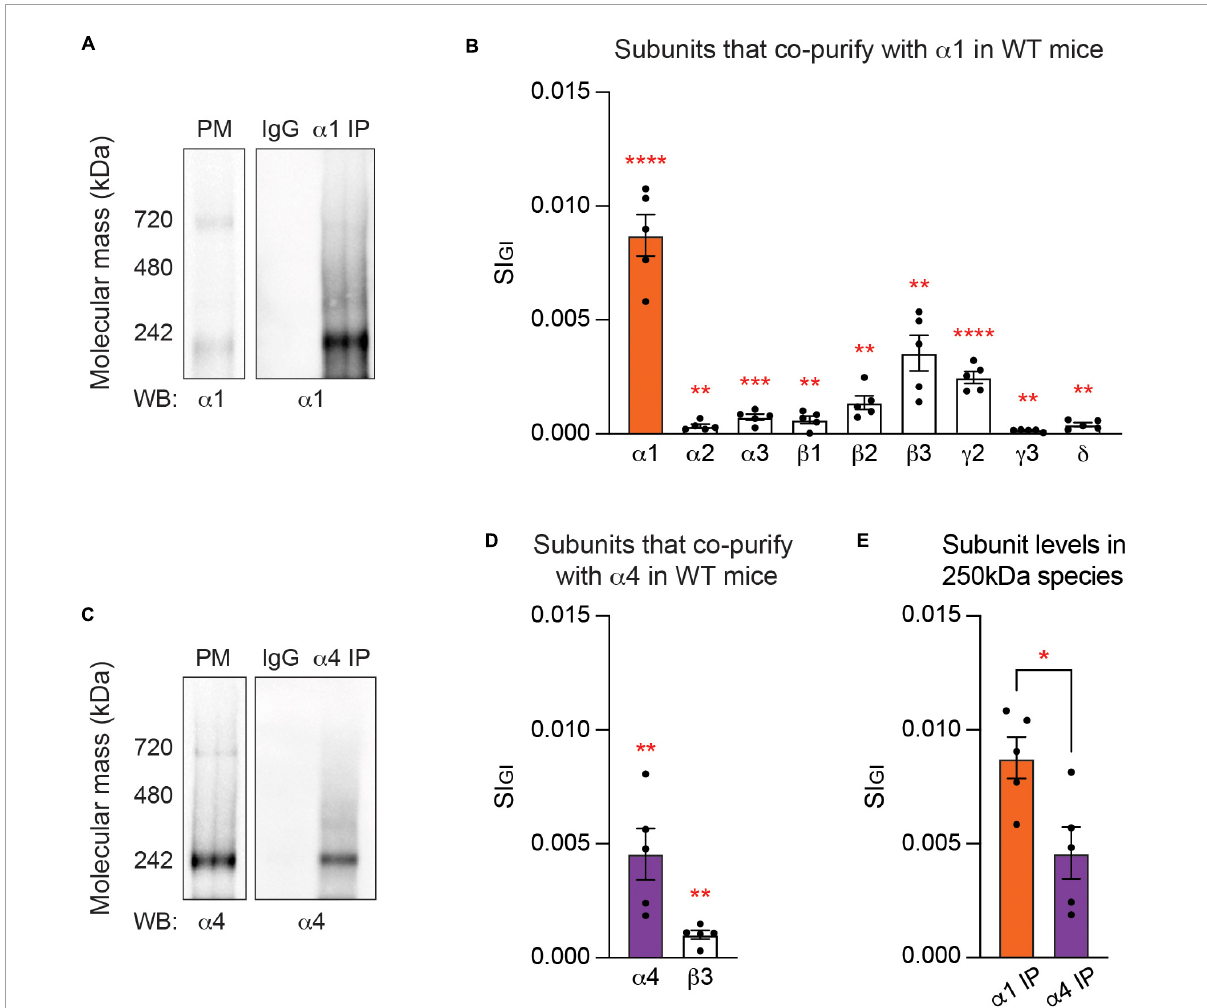
FIGURE1 At steady state, the endogenous α 1 and α 4 subunits are segregated into distinct GABA A subtypes. (A) Purified plasma membrane fraction (PM), PM exposed to non-immune IgG, and PM exposed to the α 1 subunit antibody for purification of GABA A Rs that contain the α 1 subunit ( α 1 IP) were resolved on Blue Native PAGE (BN-PAGE) gels and probed for the α 1 subunit. Major bands at around 250 and 720 kDa, which represent heteropentameric GABA A Rs in isolation and heteropentameric GABA A Rs with binding partners, respectively, were observed. (B) Gel regions containing the 250 kDa band were subjected to liquid chromatography coupled with tandem mass spectrometry (LC-MS/MS). Analysis of